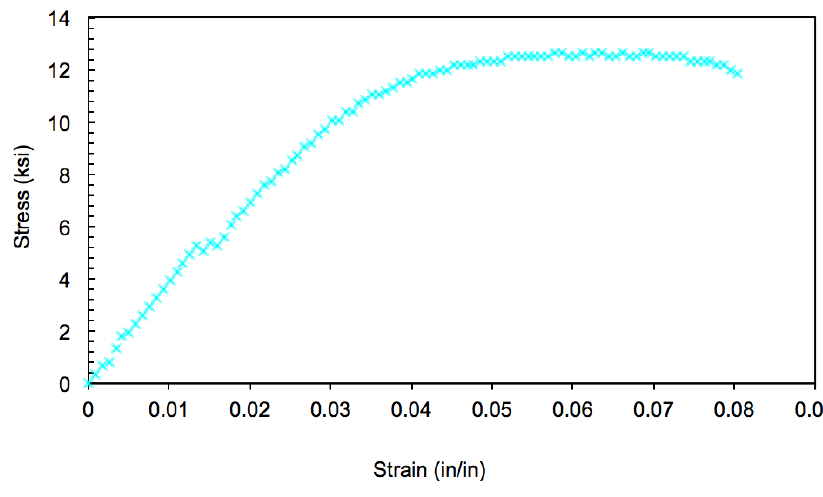
Figure A1. Stress-strain curve.